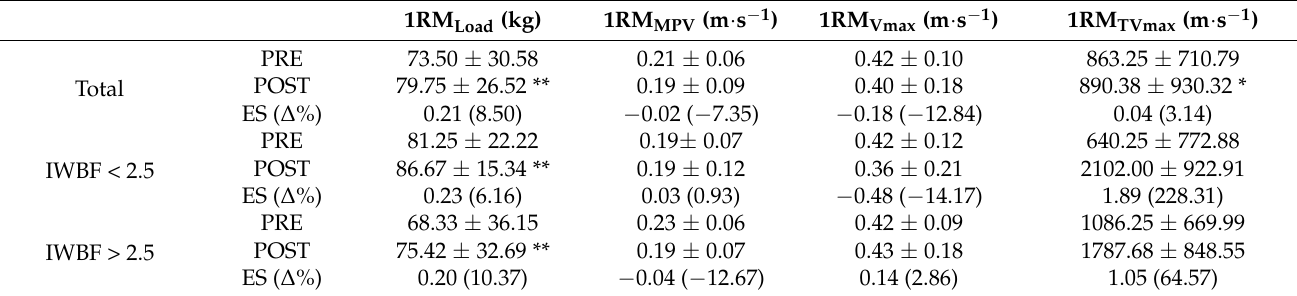
Table 2. 1RM values obtained in the pretest and in the posttest for the total of participants, as well as for each of the groups attending to the functional classification (<2.5 and >2.5).